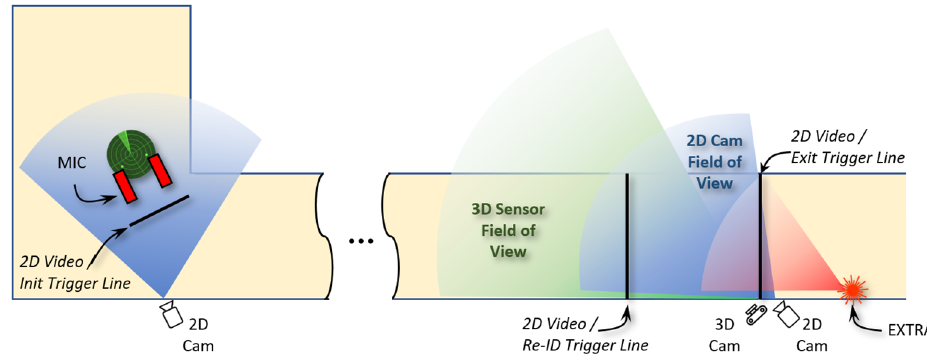
Figure 9. Map of the environment at the Anagnina metro station.